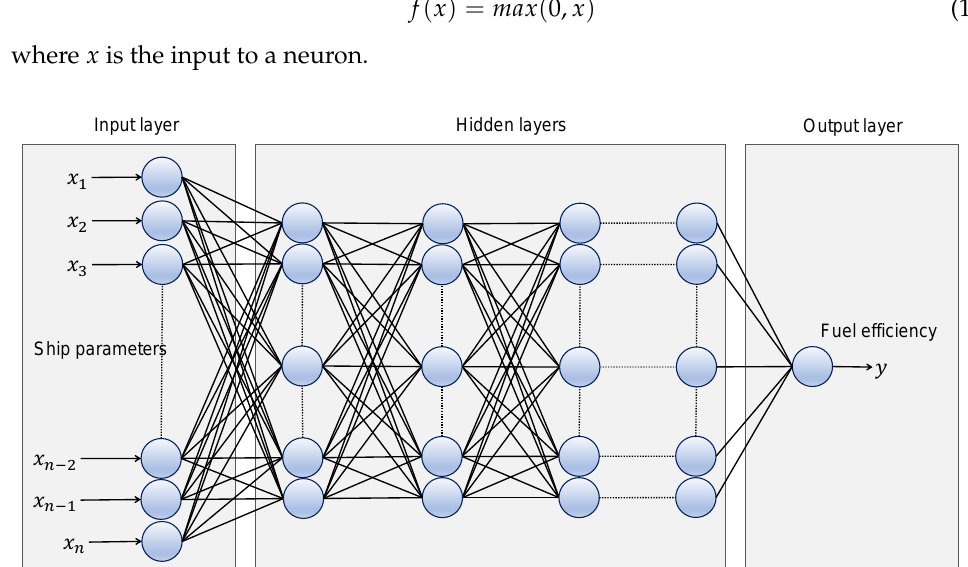
Figure 6. Architecture of a multilayer perceptron.